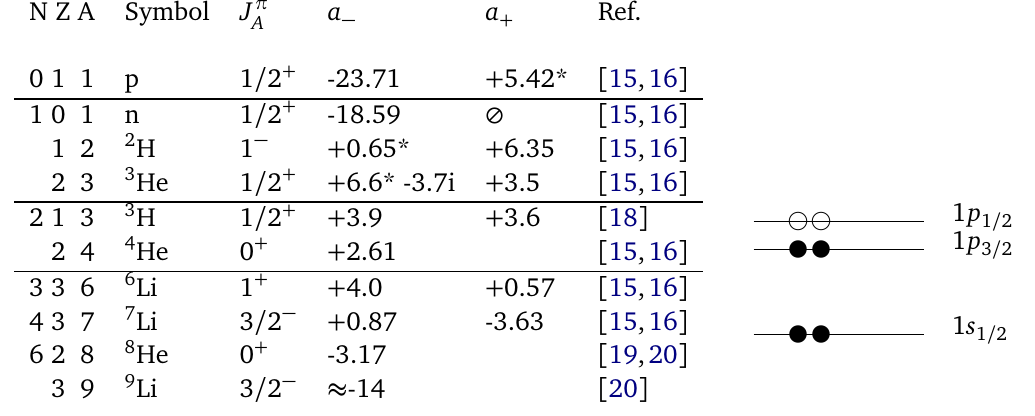
± 1 / 2 total spin state, keeping a A